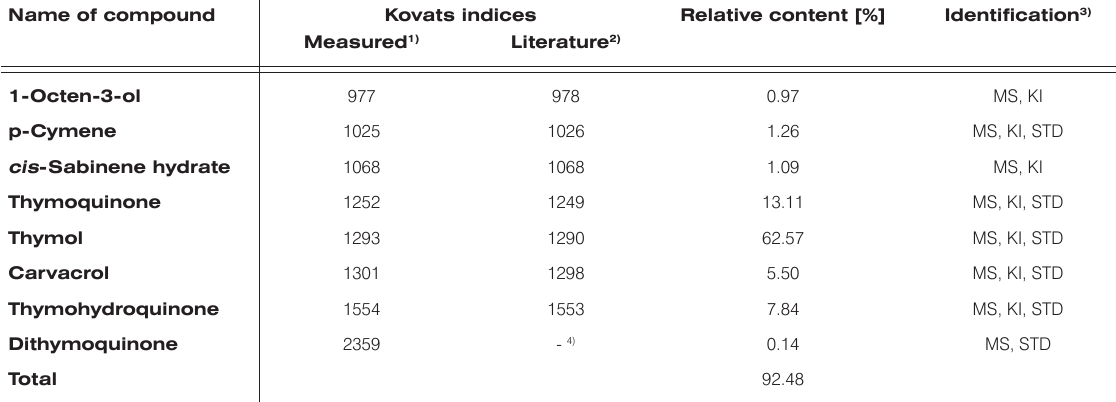
Table 2. The main components of hexane/methanol extract from Monarda didyma inflorescences (chemotype 2). Name of